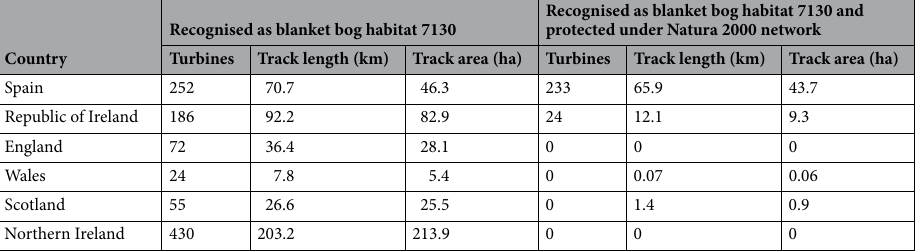
Table 2. Windfarm developments on recognised blanket bog habitat 7130 compared with recognised blanket bog habitat within a Natura 2000 site. No relationship between the extent of recognised blanket bog and number of turbines ( p = 0.30), length of tracks ( p = 0.40) and total affected area ( p = 0.46) was